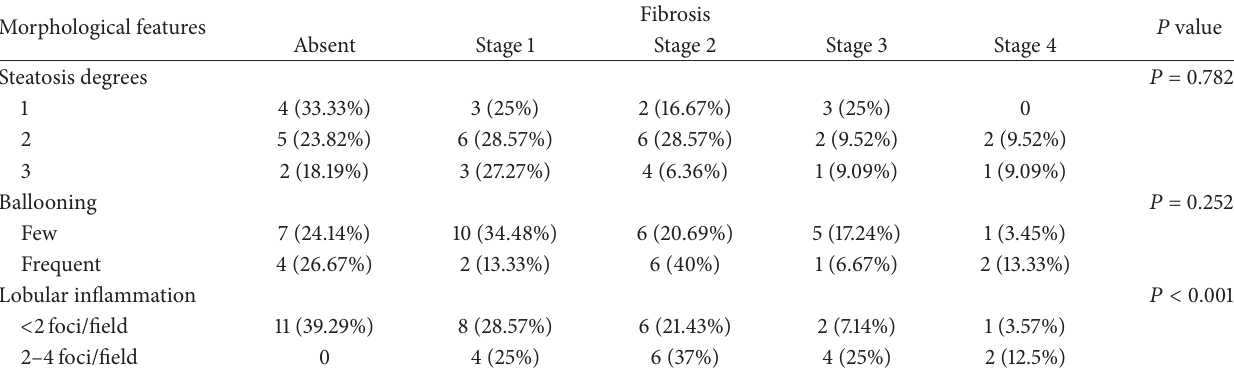
Table 2: Association between morphological features and fibrosis grade in NASH biopsies according to Bedossa’s histological algorithm. Morphological features